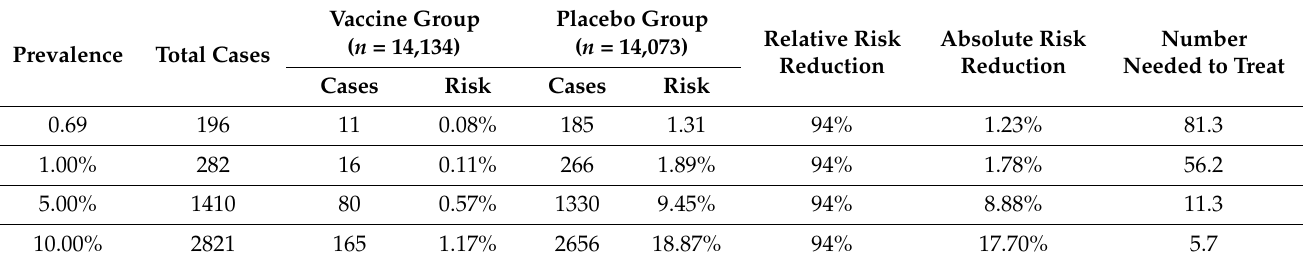
Table 2. Effects of increasing prevalence of disease affecting ARR with a constant RRR in the mRNA- 1273 study (total population: 28,207)